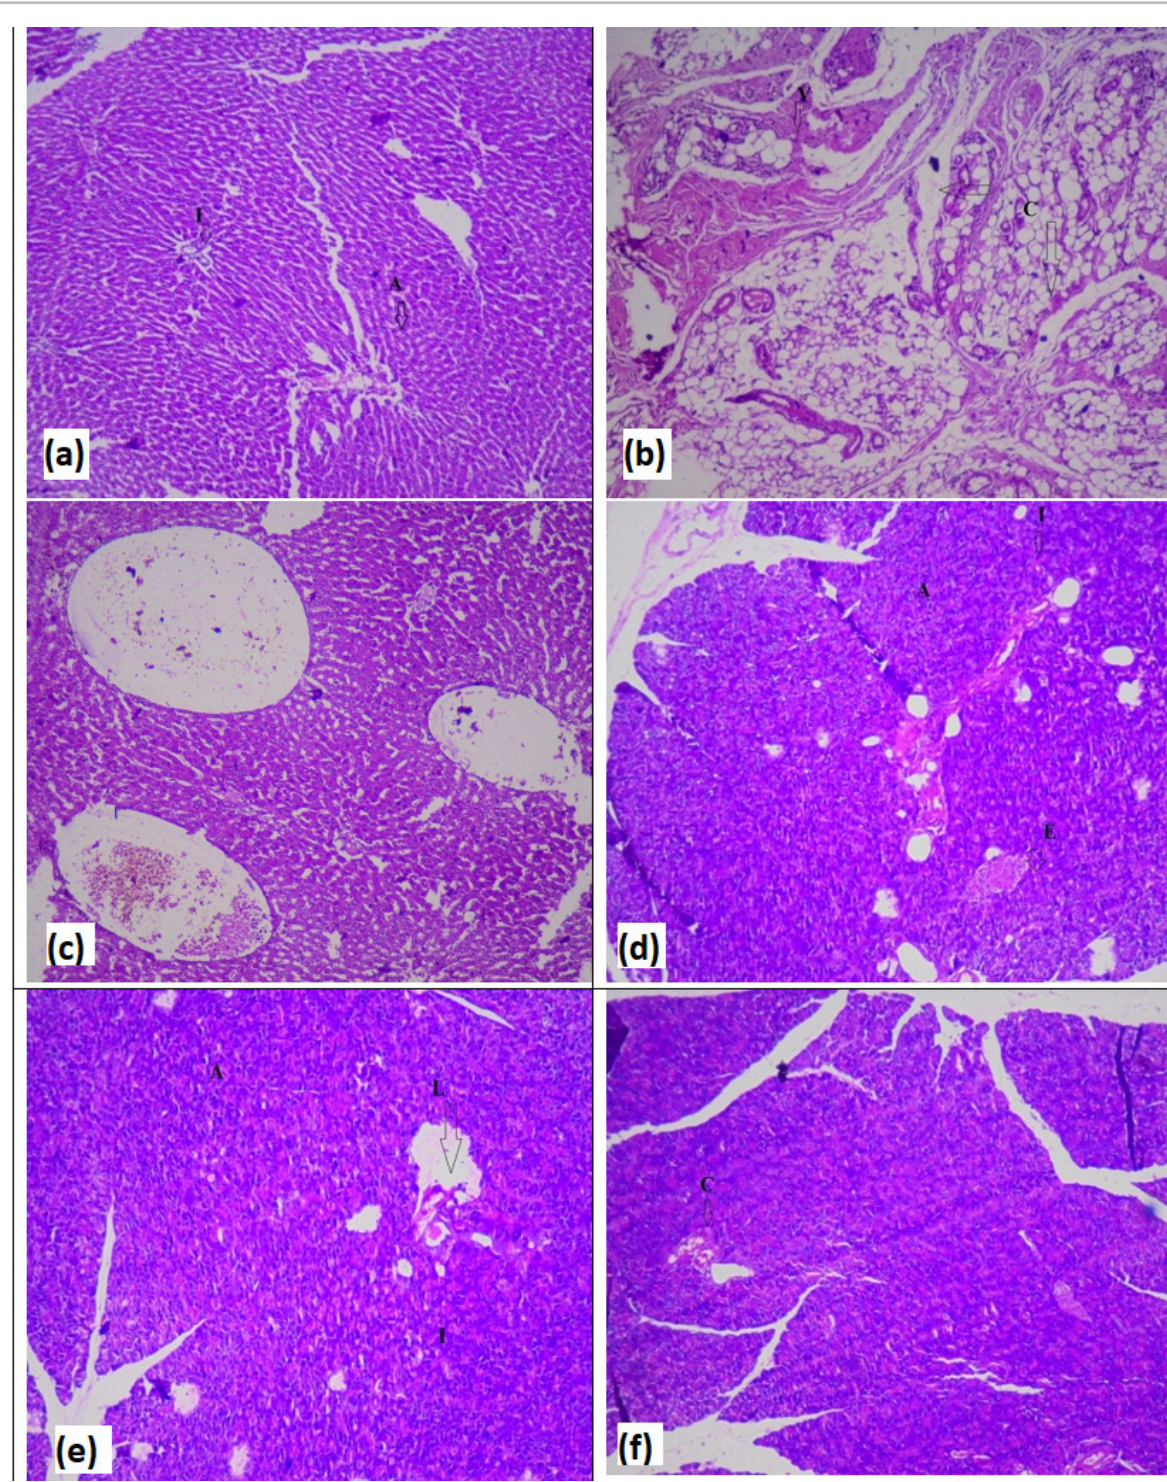
FIGURE 3 – Histopathological examination of pancreatic tissues (a) Photomicrograph of normal control rats showed normal acinar and islet cells of the pancreas (b) Photomicrograph of untreated diabetic rats showed showing congestion and slight vacuolization of islets of Langerhans cells (c) Photomicrograph of Glibenclamide treated diabetic rats showing mild abnormal septa (s) and congestion in the blood vessels (d) Pancreas of rats treated with 250 mg/kg plant extract showing normal acinar cells and heavy infiltration of eosinophils in and around islet cells (e) Pancreas of rats treated with 500 mg/kg extract showing normal acinar cells and the infiltration of eosinophils in islets (f) Photomicrograph of diabetic rats treated with 750 mg/kg plant extract showing the presence of islet cells in smaller amount than untreated diabetic